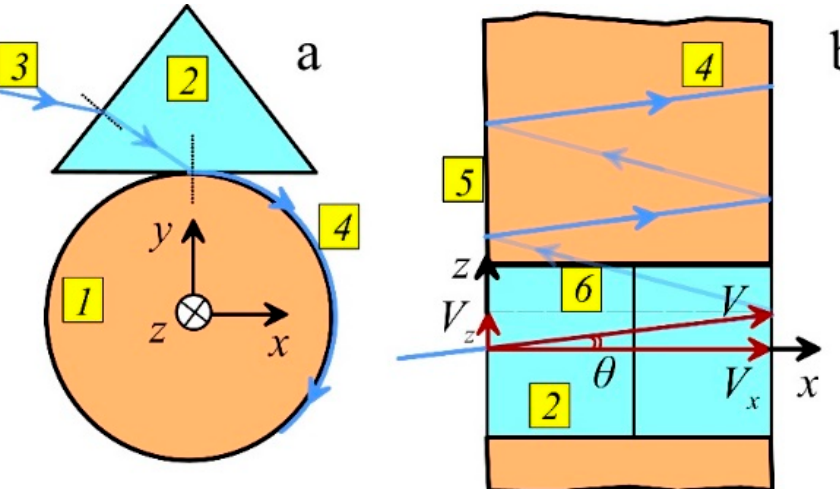
Figure 1. Geometry of optical radiation entering the cylindrical waveguide ( a ) waveguide cross section, ( b ) top view of the prism and fiber). 1—waveguide, 2—prism, 3—input radiation, 4—surface wave, 5—cylinder axis, 6—cylinder cross section; θ is the angle between the direction of radiation input into the cylindrical waveguide, 3 and cylinder cross-section, 6. V , V z , and V x are the velocity and its longitudinal and transverse components, respectively.